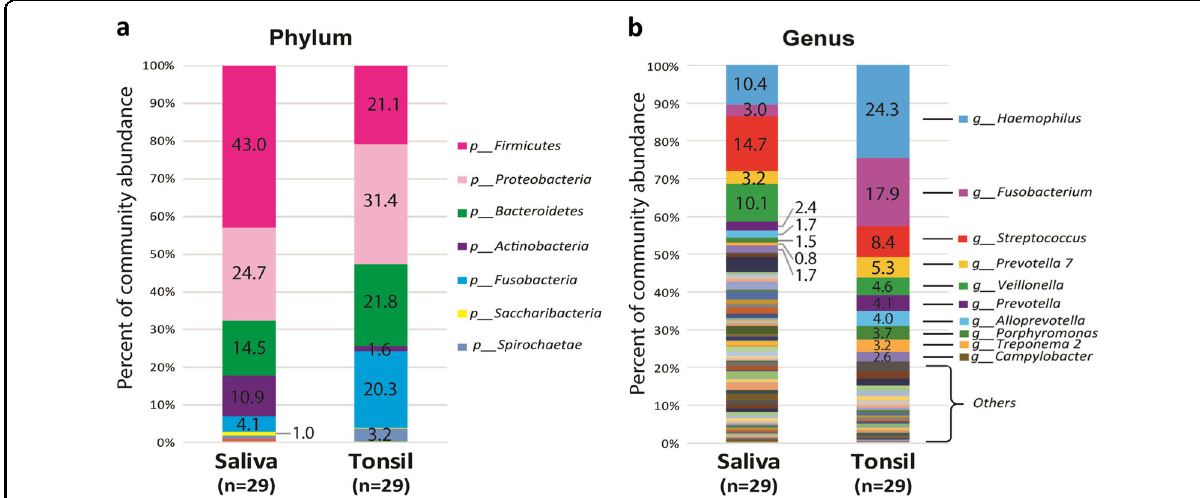
Fig. 1 Microbiota compositions of saliva and tonsil samples from 29 participants. Relative abundance at a phylum level and b genus level from 29 participants. The relative abundance of the microbial community based on the dominant phyla and genera. The highly abundant phyla were